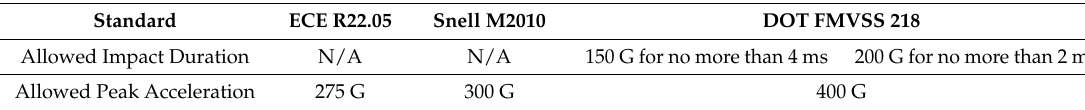
Table 1. Basic requirements of motorcycle helmet safety standards.